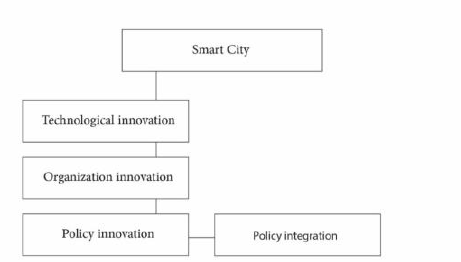
Figure 4 . Smart city elements, illustrated by